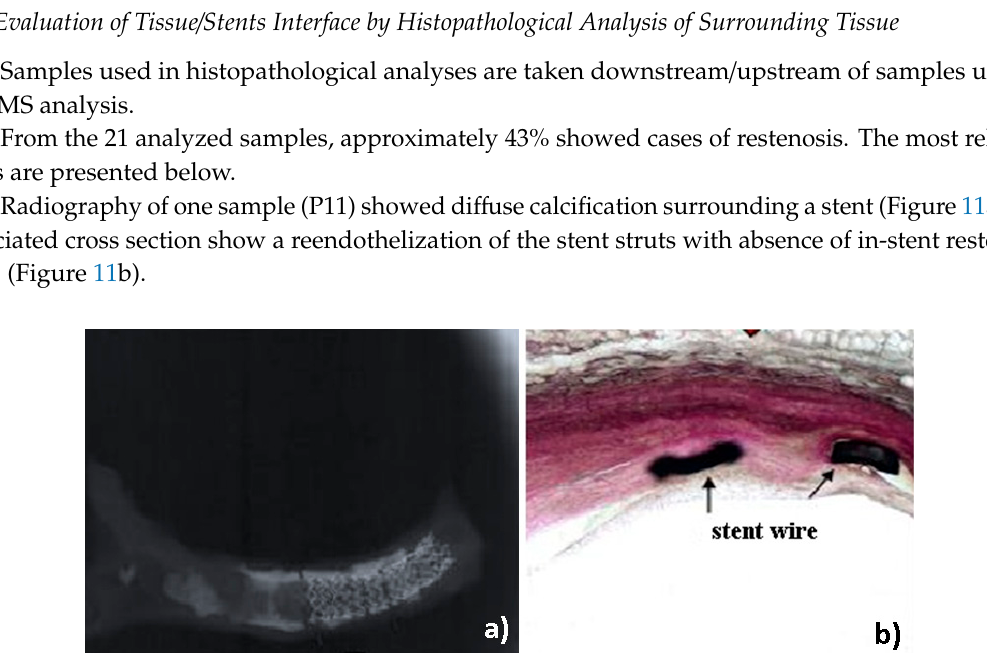
Figure 11. ( a ) Radiography and ( b ) associated cross section of sample P11.